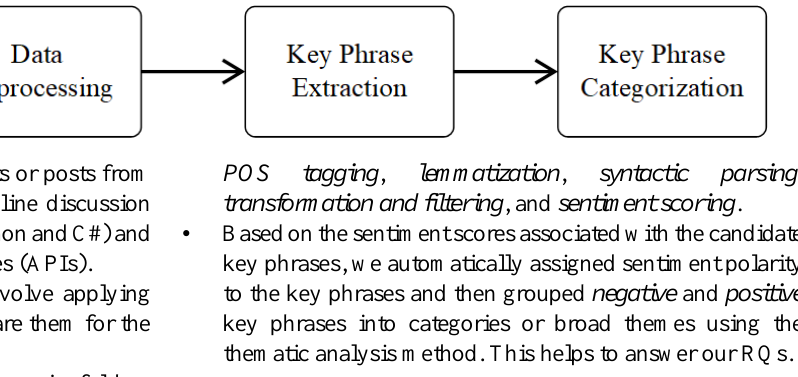
Figure 1. Methodological